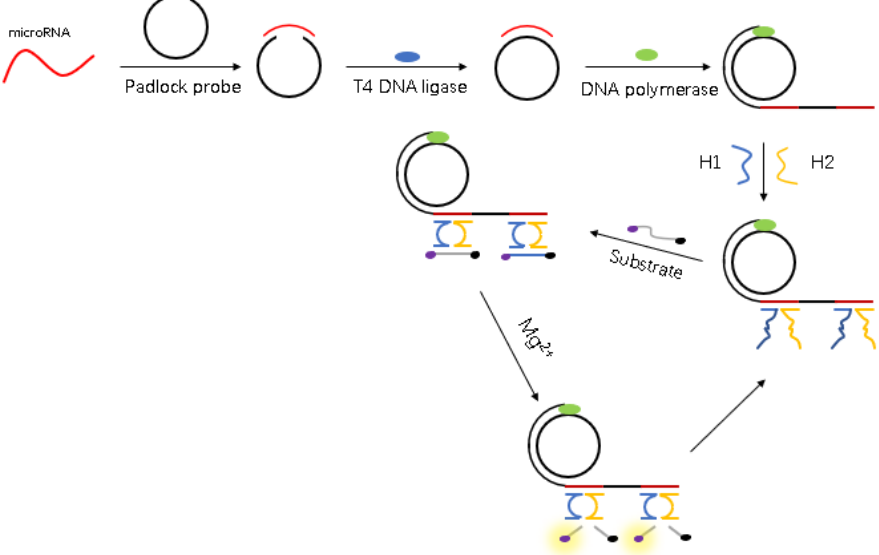
Figure 1. Schematic illustration of the fluorescence assay for the detection of miR-21 using RCA and DNAzyme.